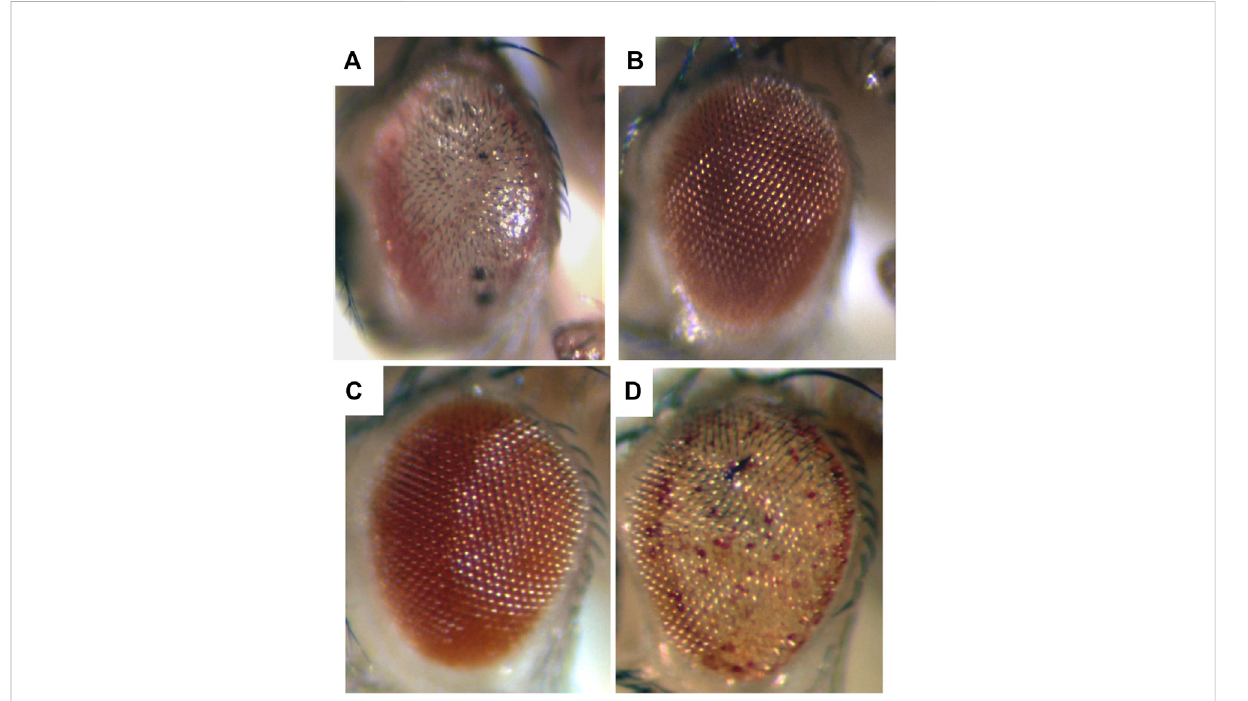
FIGURE 1 Expression of a toxic human neurodegenerative polyQ protein causes degeneration in the fl y, and is modulated by up and downregulation of chaperone activity. Flies expressing (A) the toxic Spinocerebellar type 3 (SCA3) disease protein strongly have a very severe degeneration. (B) Coexpression with Hsp70 prevents degeneration and the eye returns to normal. By comparison, (C) animals expressing the SCA3 disease protein weaklyarebornwithafairlynormalexternaleye.However (D)